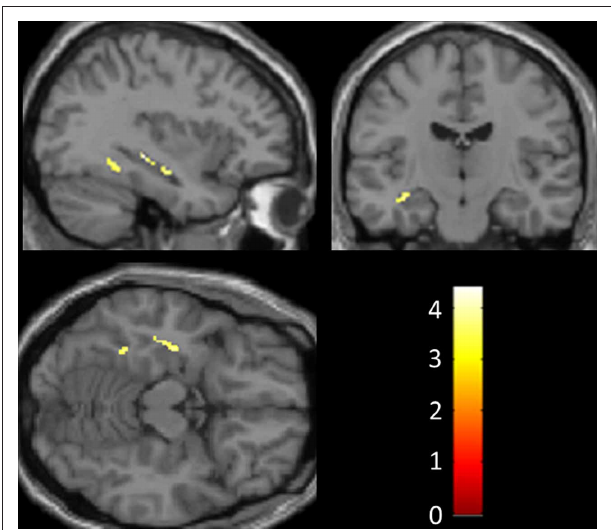
FIGURE 1 | Statistical parametric maps of regions of significant gray matter preservation in the musicophilic relative to the non-musicophilic patient subgroup (shown at an uncorrected threshold p < 0 . 001; atrophy of left hippocampus significant at p < 0 . 05 after small volume correction for multiple voxel-wise comparisons). All gray matter correlates with cluster size > 20 voxels are shown. SPMs are displayed on sagittal (above left), coronal (above right), and axial (below left) sections through the anterior temporal lobes from a canonical T1 weighted brain template image in Montreal Neurological Institute standard stereotactic space. The sagittal section is through the left cerebral hemisphere; the coronal section shows the left hemisphere on the left. Z scores are coded on the color bar (below